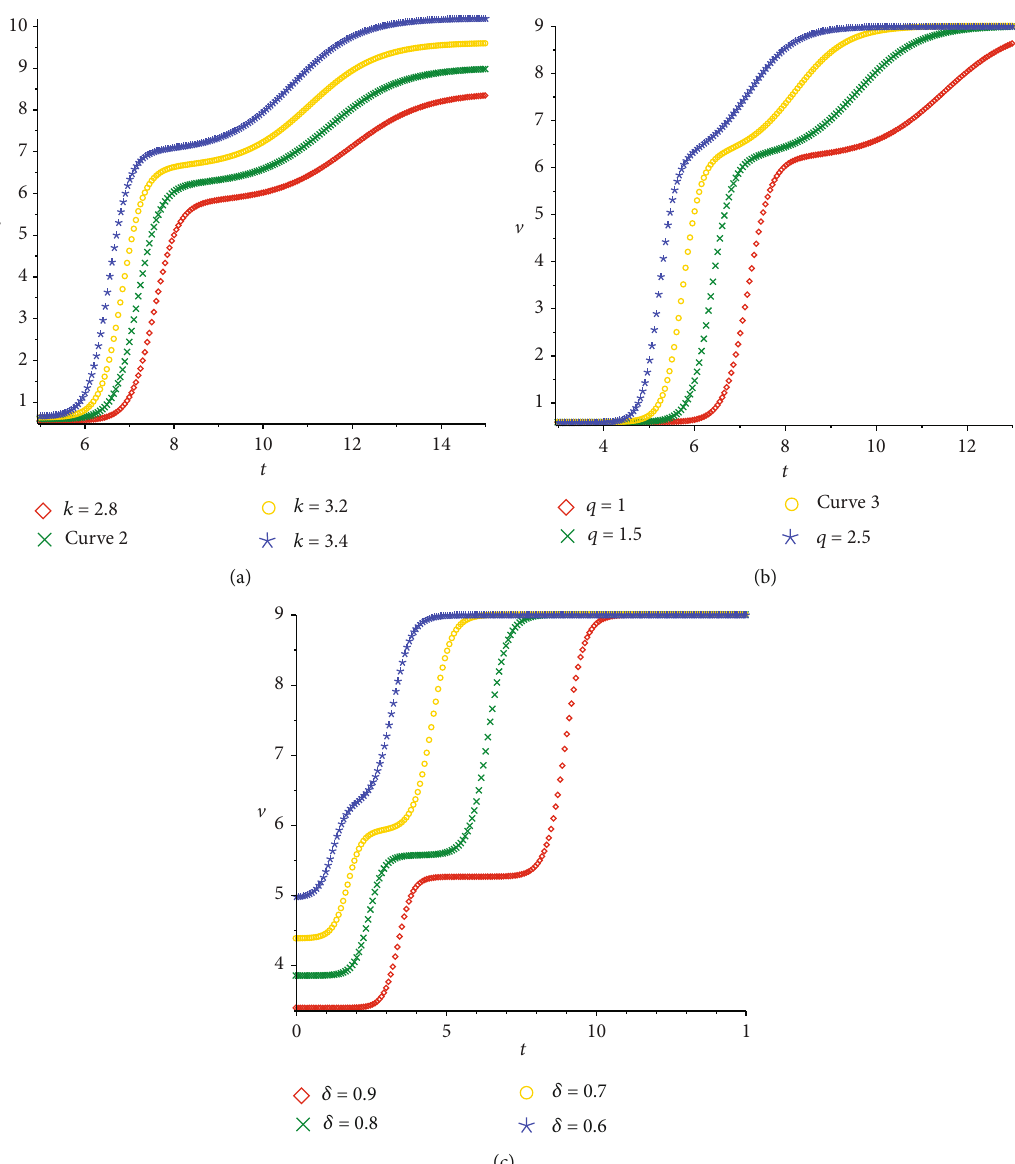
Figure 6: Two shock waves for l